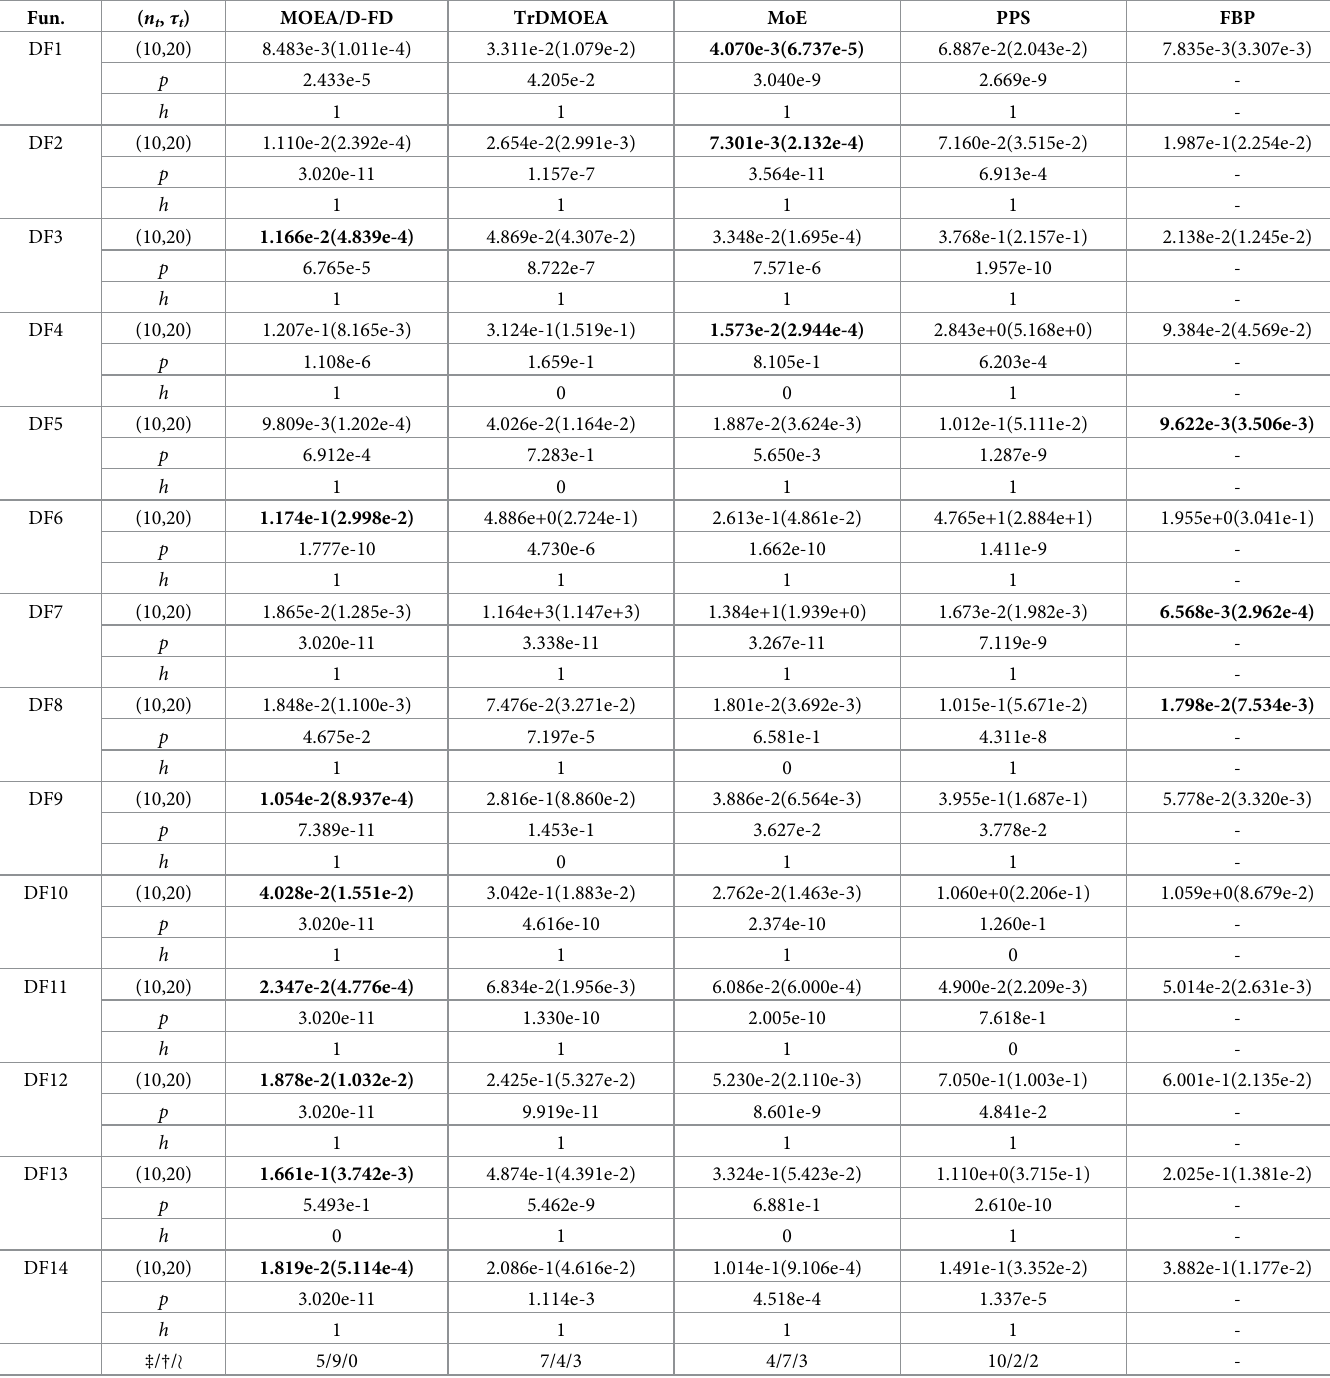
Table 9. Mean and standard deviation values of MSP obtained by five algorithms for ( n t , τ t ) = (10,20).